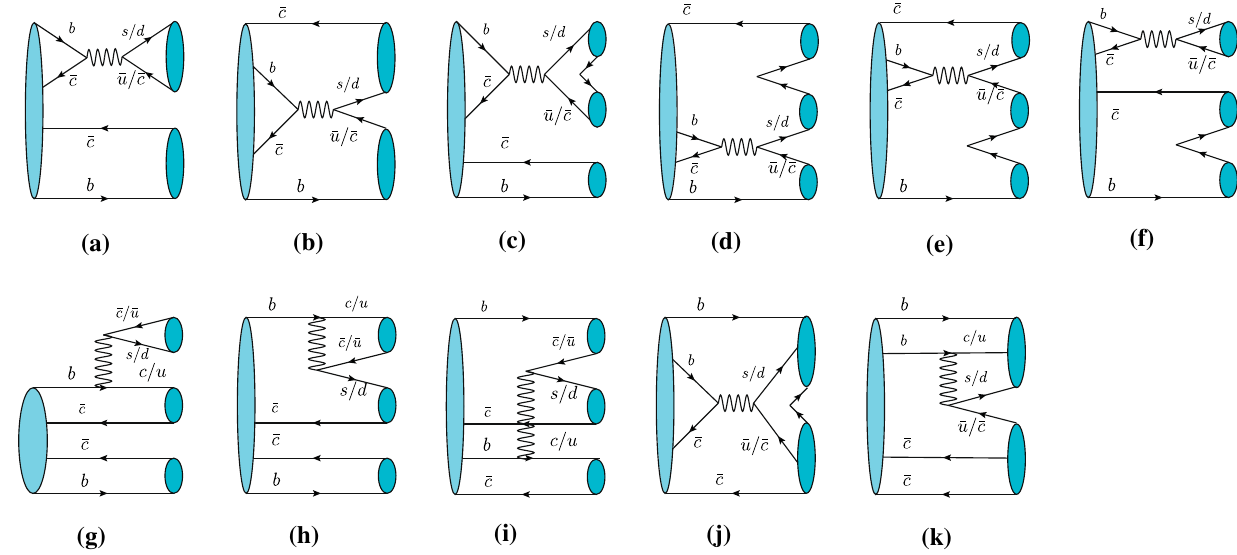
{ bb } Fig. 4 The Feynman diagrams for T {¯ c ¯ c } non-leptonic decays within b quark decay. Panels a , b represent the two-body mesonic decays, two-body baryonic decays are shown in panels j , k and the panels c – i indicate the three-body mesonic